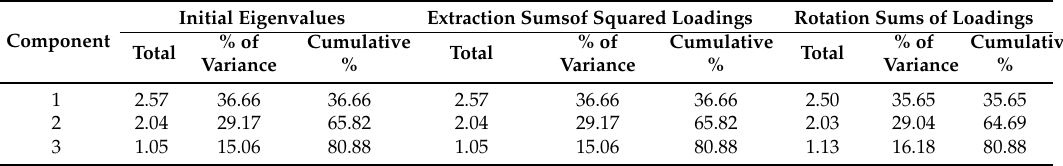
Table 7. Total variance and component matrixes for HMs in sewage sludge.